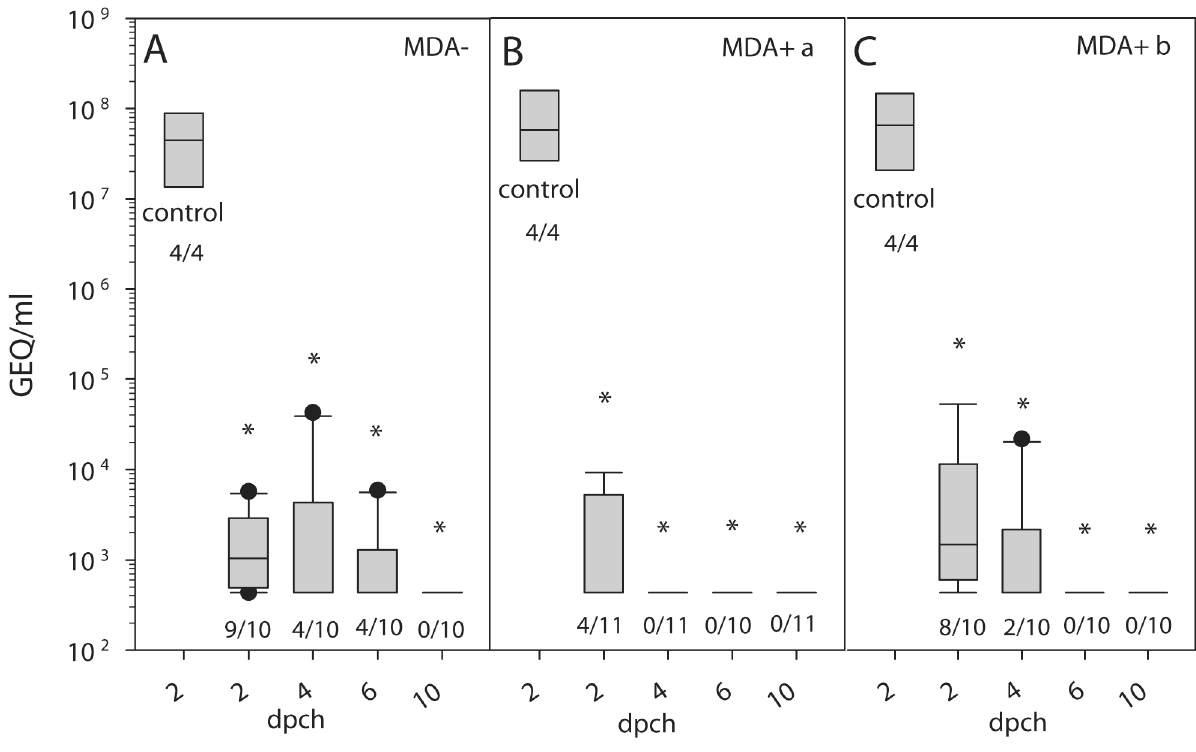
Figure 8. Virus shedding after challenge infection. Combined oropharyngeal and cloacal swabs of MDA- (A) and MDA+ chickens immunized on day 1 (group a (B)) or day 7 (group b (C)) were analyzed after challenge for presence of AIV NP gene- specific sequences by RT-qPCR. Values were transformed to genome equivalents (GEQ) using calibration curves of defined RNA standards that were included with each RT-qPCR run. The number of positive swabs by RT-qPCR is given below the box plots. Significant differences (P < 0.0125, Bonferroni correction) between vaccinated groups and controls are indicated (*).